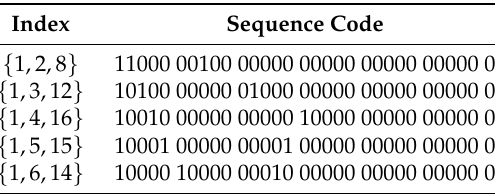
Table 5. OOC ( 31,3,1 ) sequences.